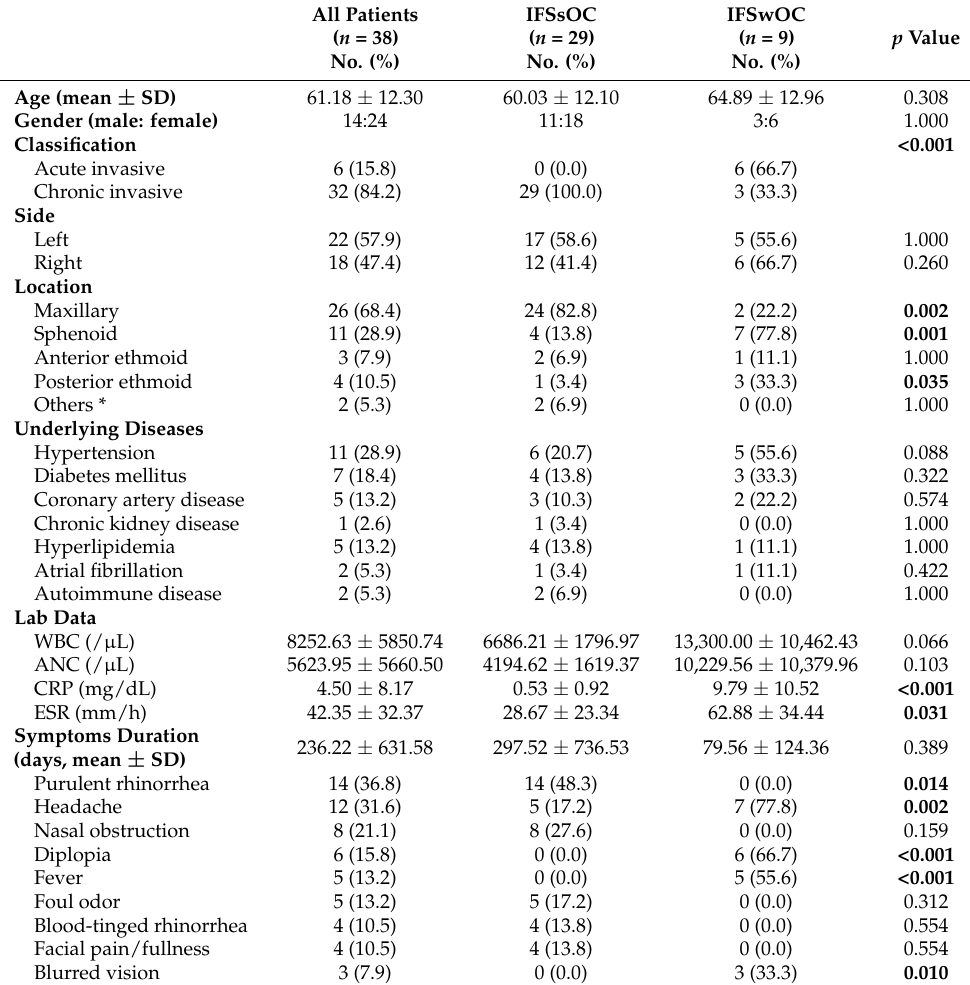
Table 1. Comparison of demographic data, lab data, symptoms and imaging results between IFSsOC and IFSwOC.